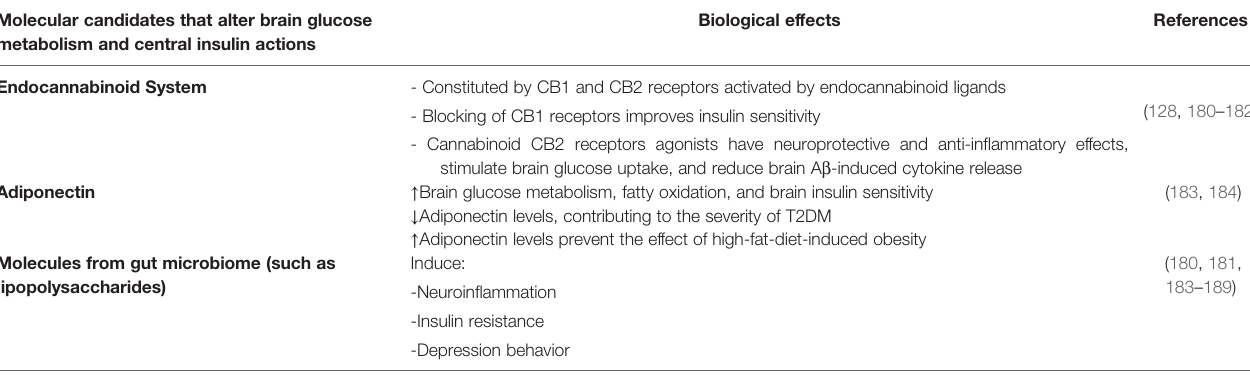
TABLE 4 | Roles of other molecules in addition to insulin that may modulate brain glucose metabolism and central insulin signal transduction. Molecular candidates that alter brain glucose metabolism and central insulin